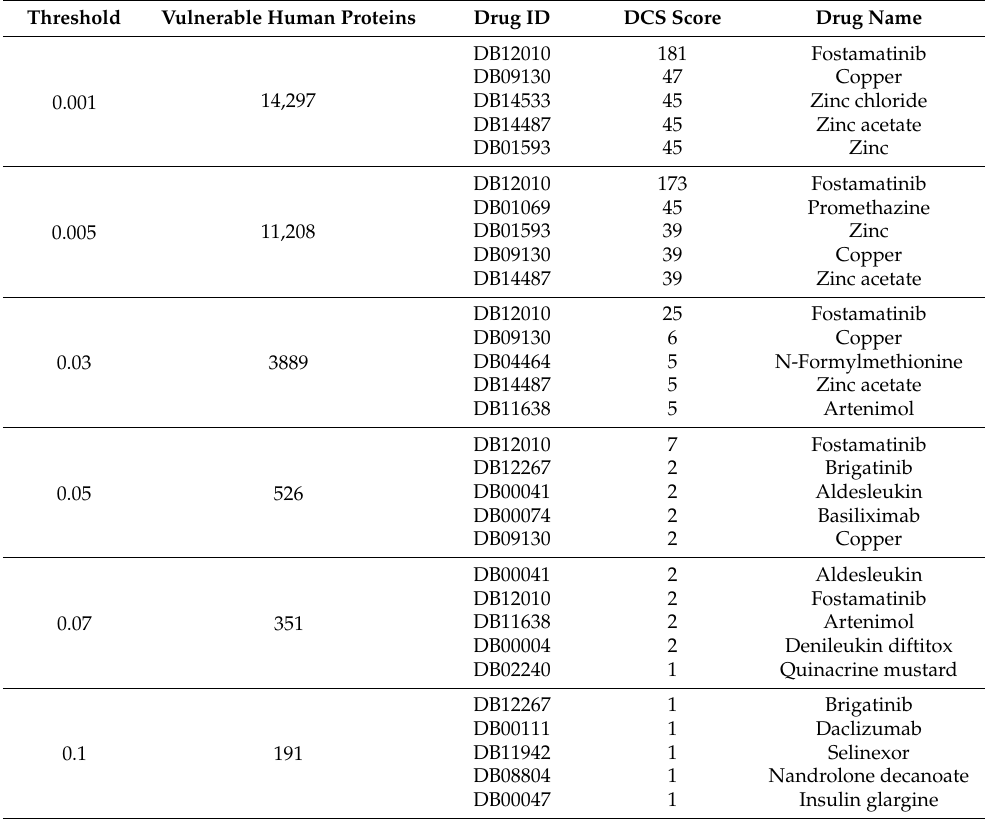
Table 10. Top 5 target drugs with their respective DCS score at different threshold